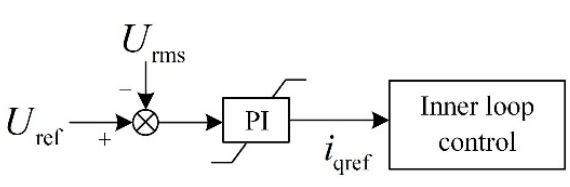
Fig. 4. Schematic diagram of constant AC voltage